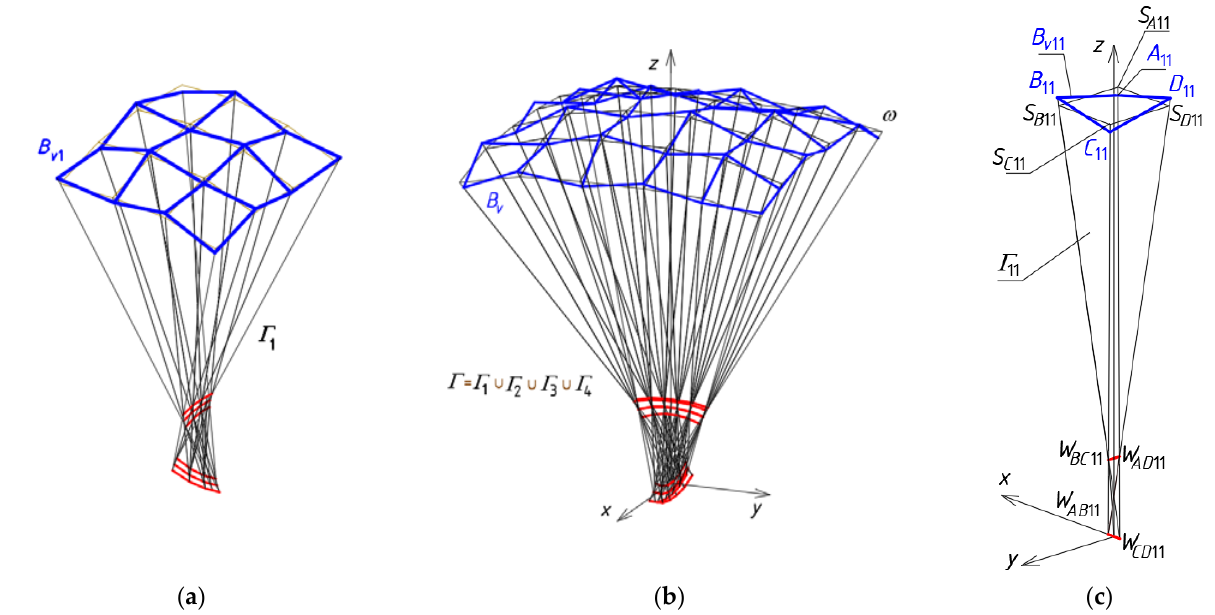
Figure 13. The polyhedral and quadrilateral nets for a continuous roof structure: ( a ) the one-fourth Γ 1 of Γ and the one-fourth B v 1 of B v ; ( b ) the entire Γ and B v networks; ( c ) the central meshes Γ 11 and B v 11 .